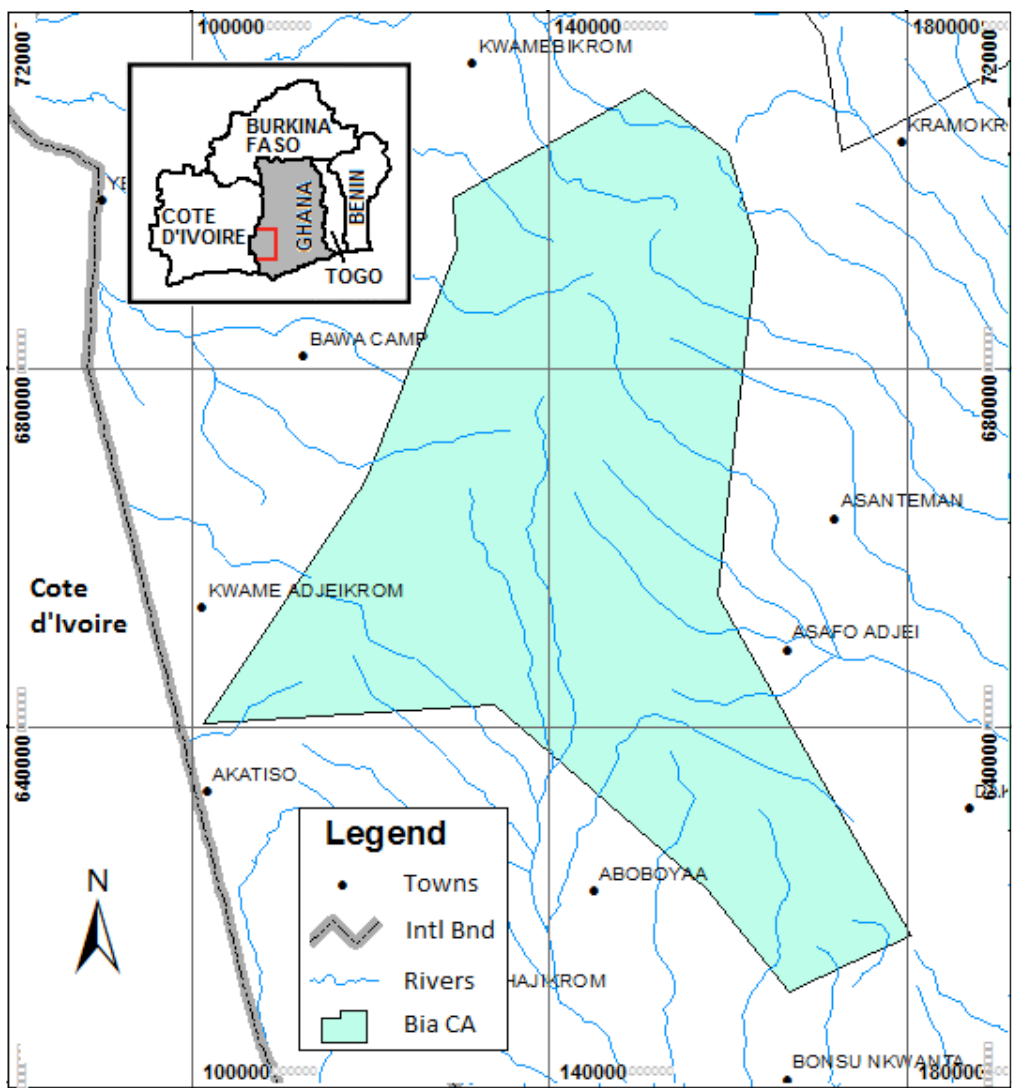
Figure 1. The Bia Conservation Area (BCA). The inset map shows the location of BCA in